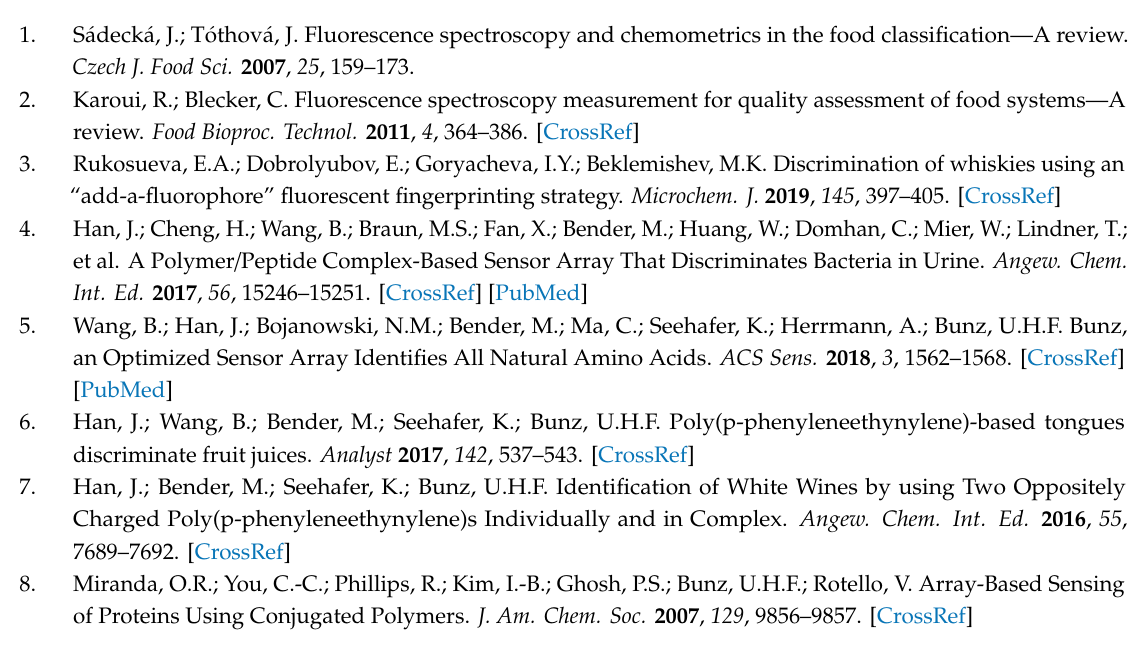
Figure S1: Fluorescence spectra of honey samples with added fluorophores: (a) intercalated thiazole orange, (b) Ru(bpy) 32 + . Figure S2. Scores plots of the visible region reflection images of honey samples in the 96-well plates. Table S1. The number of discriminated groups of points in the scores plots of 23 honey samples with added thiazole orange (TO) intercalated into DNA-2 (TO–DNA-2 fluorophore); standard formulas for the calculation of confidence ellipses; Matlab function for relative position (RP)